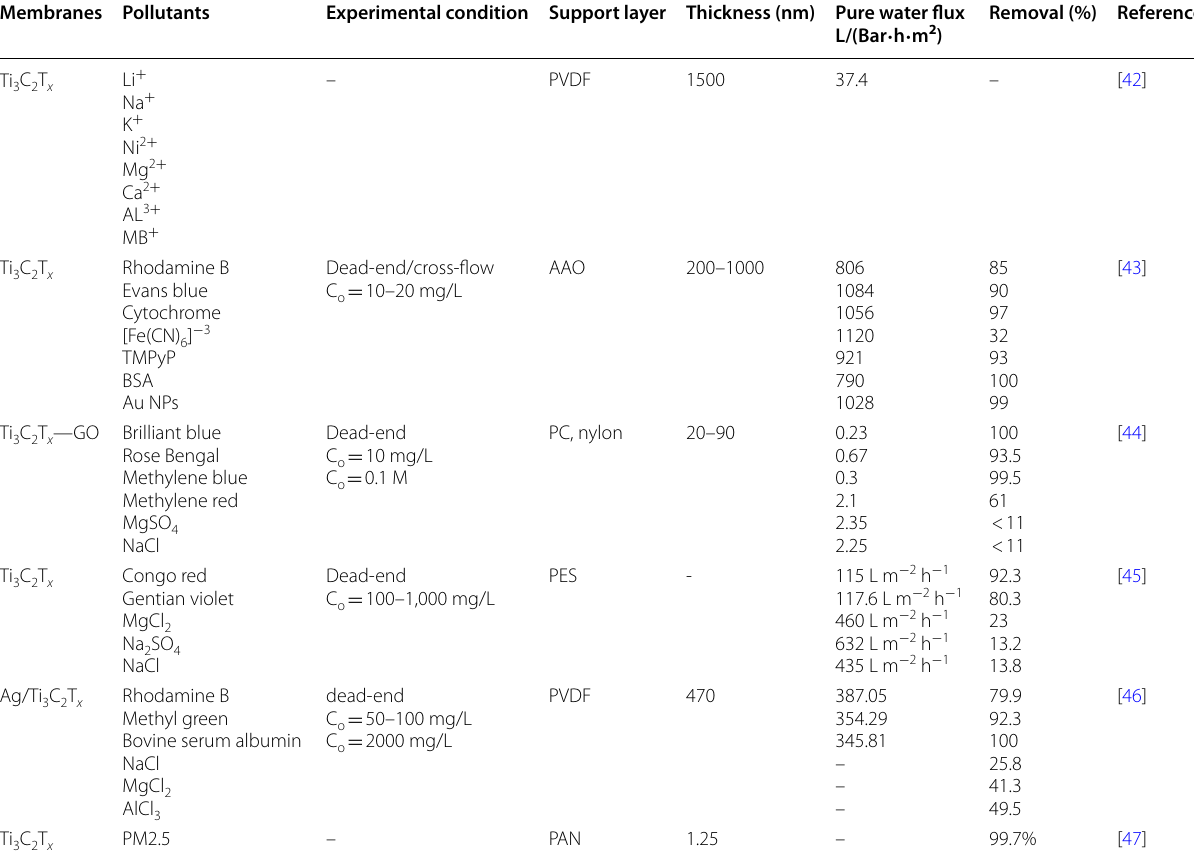
PVDF polyvinylidene difluoride, AAO anodic aluminum oxide, PC polycarbonate, PES : polyethersulfone, PAN polyacrylonitrile